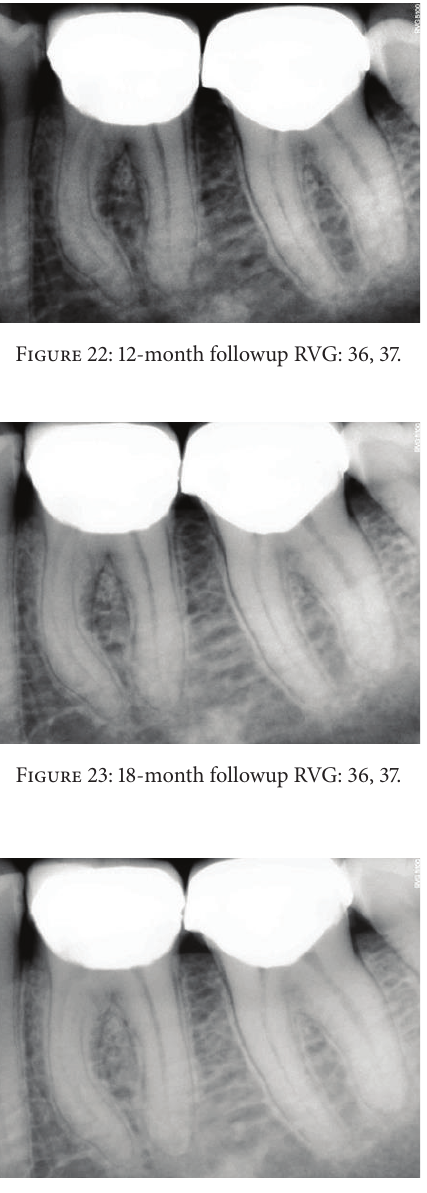
Figure 24: 22-month followup RVG: 36, 37.